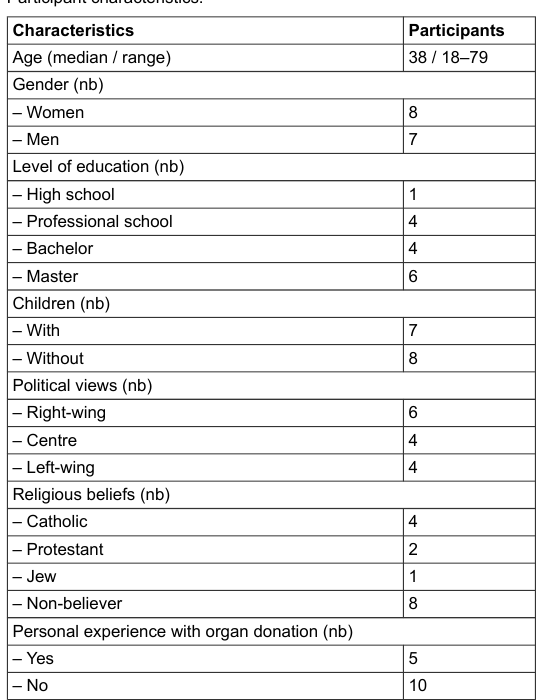
Table 1: Participant